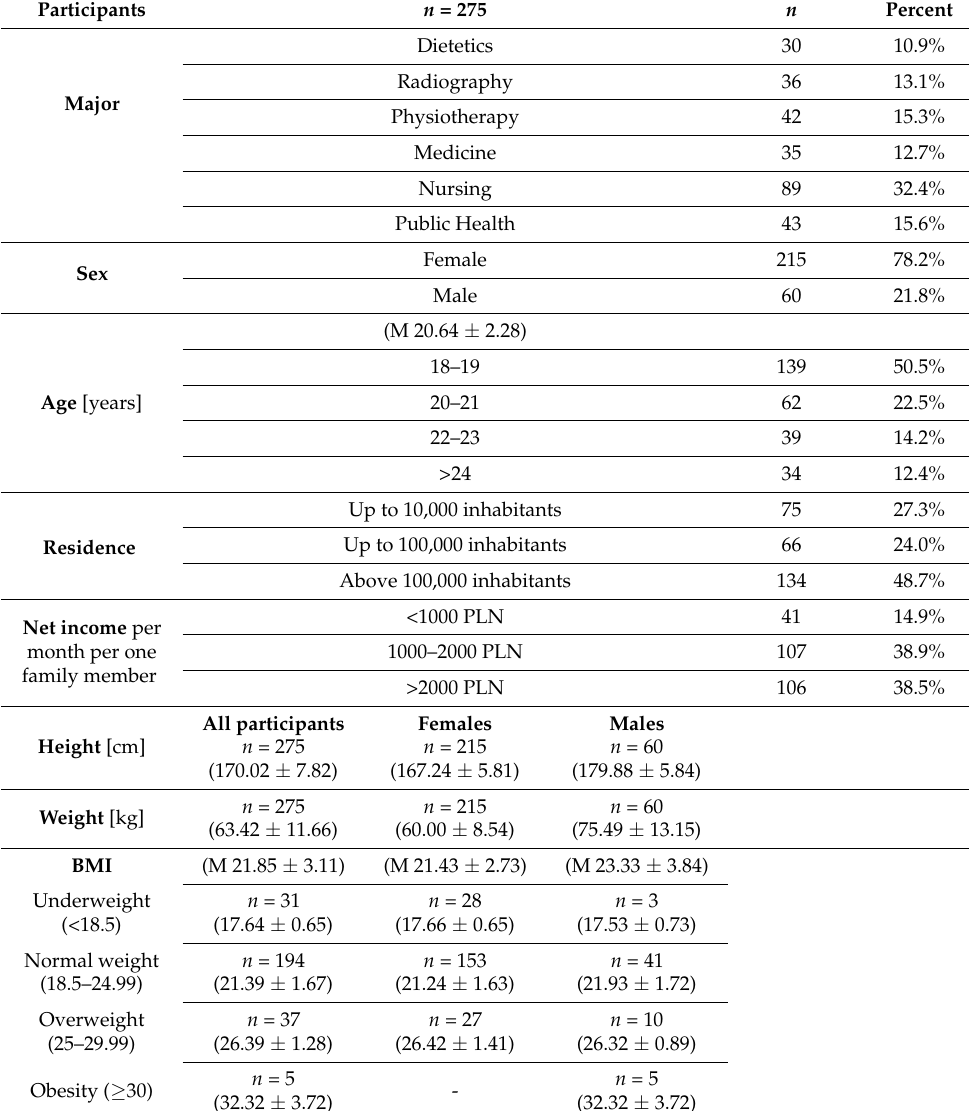
Table 1. Study sample